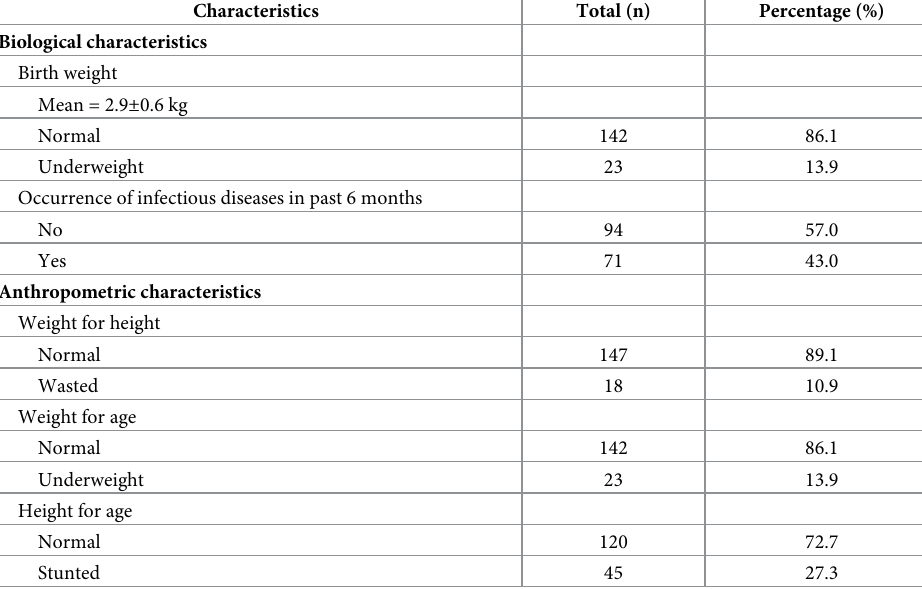
Table 4. Biological and anthropometric